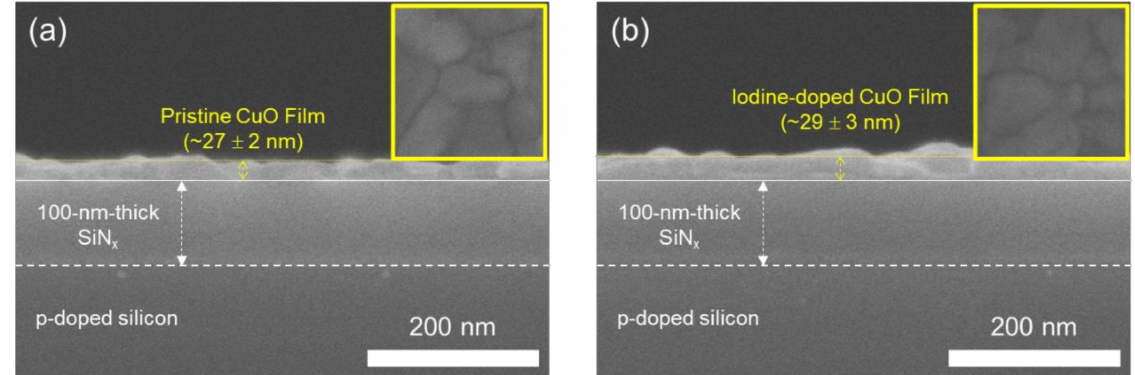
Figure 4. Cross-sectional FE-SEM images of ( a ) pristine and ( b ) iodine-doped CuO films. Insets show the top-view FE-SEM images (100 nm × 100 nm) of films.